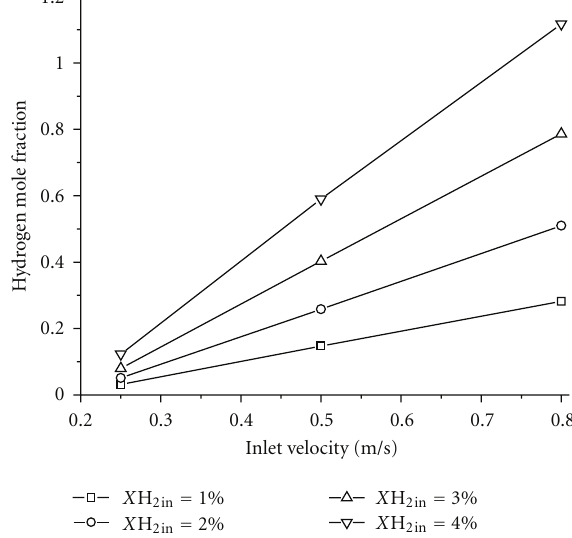
Figure 10: Maximum catalyst surface temperature as a function of inlet velocity and inlet hydrogen concentration for REKO facility with inlet temperature 383 K.